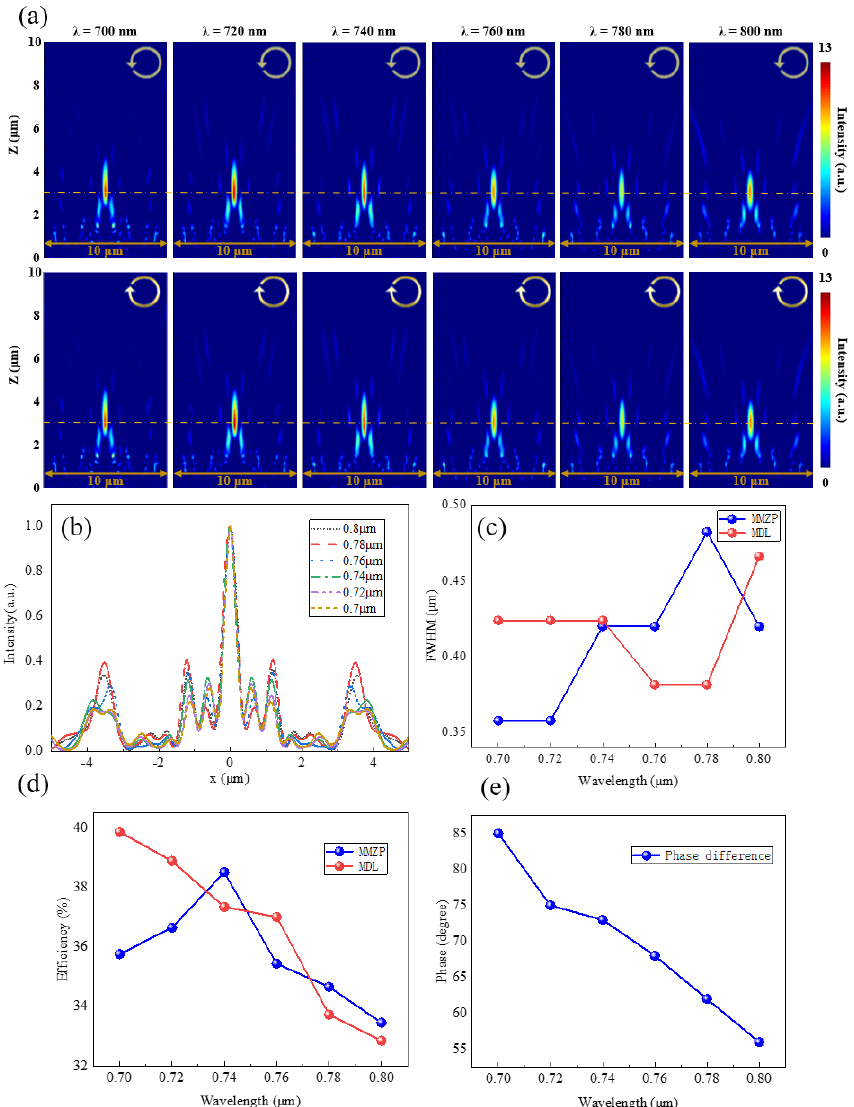
Figure 6. Focusing characteristic and polarization manipulation of the MMZP. ( a ) Numerical intensity profiles along axial planes at various incident wavelengths for LCP (top row) and RCP (bottom row) incident light. ( b ) Normalized intensity distribution of the MMZP along transversal axis ( x axis). ( c ) FWHM and ( d ) Focusing efficiency at corresponding focal plane as a function of wavelength. ( e ) Simulated phase difference of various incident wavelengths for LCP